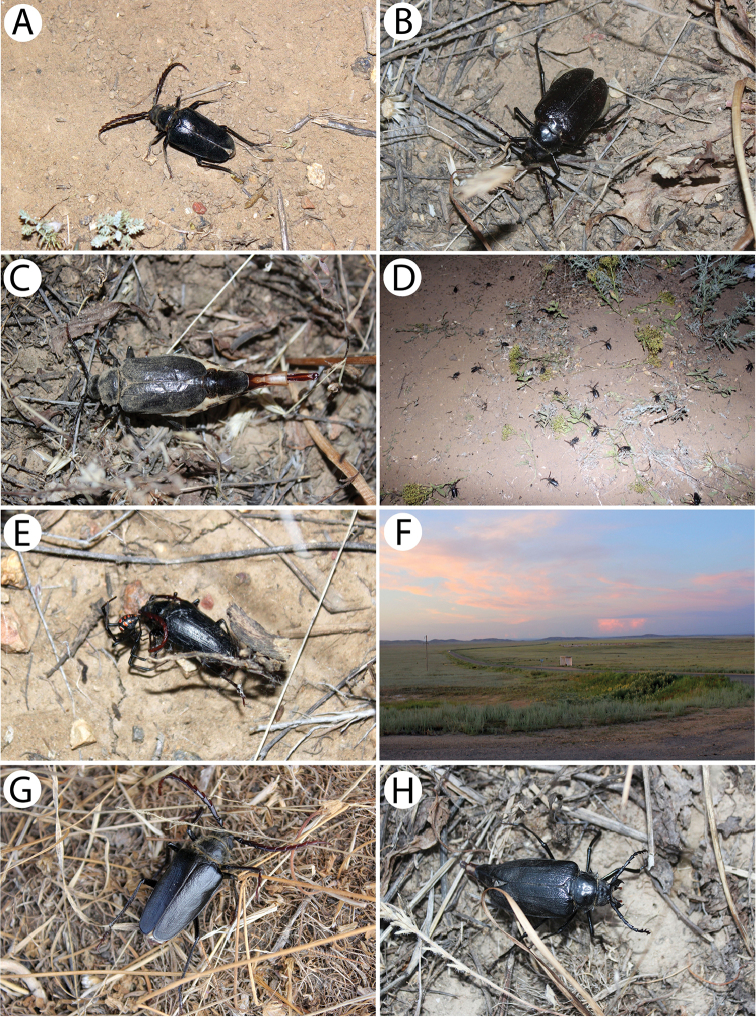
Field photos of imagines in nature and habitats of typical Kazakh cerambycid species: A male of PsilotarsusbrachypterusbrachypterusB female of P.brachypterusbrachypterusC female of P.brachypterusbrachypterus while spraying pheromones with raised ovipositor D massive occurrence of the males of P.brachypterusbrachypterus attracted to an artificial light source E male of P.brachypterusbrachypterus hunted by LatrodectustredecimguttatusFArtemisia-desert in Kurshim environs, the habitat of P.brachypterusbrachypterusG male of PsilotarsusbrachypteruspubiventrisH female of P.brachypteruspubiventris.